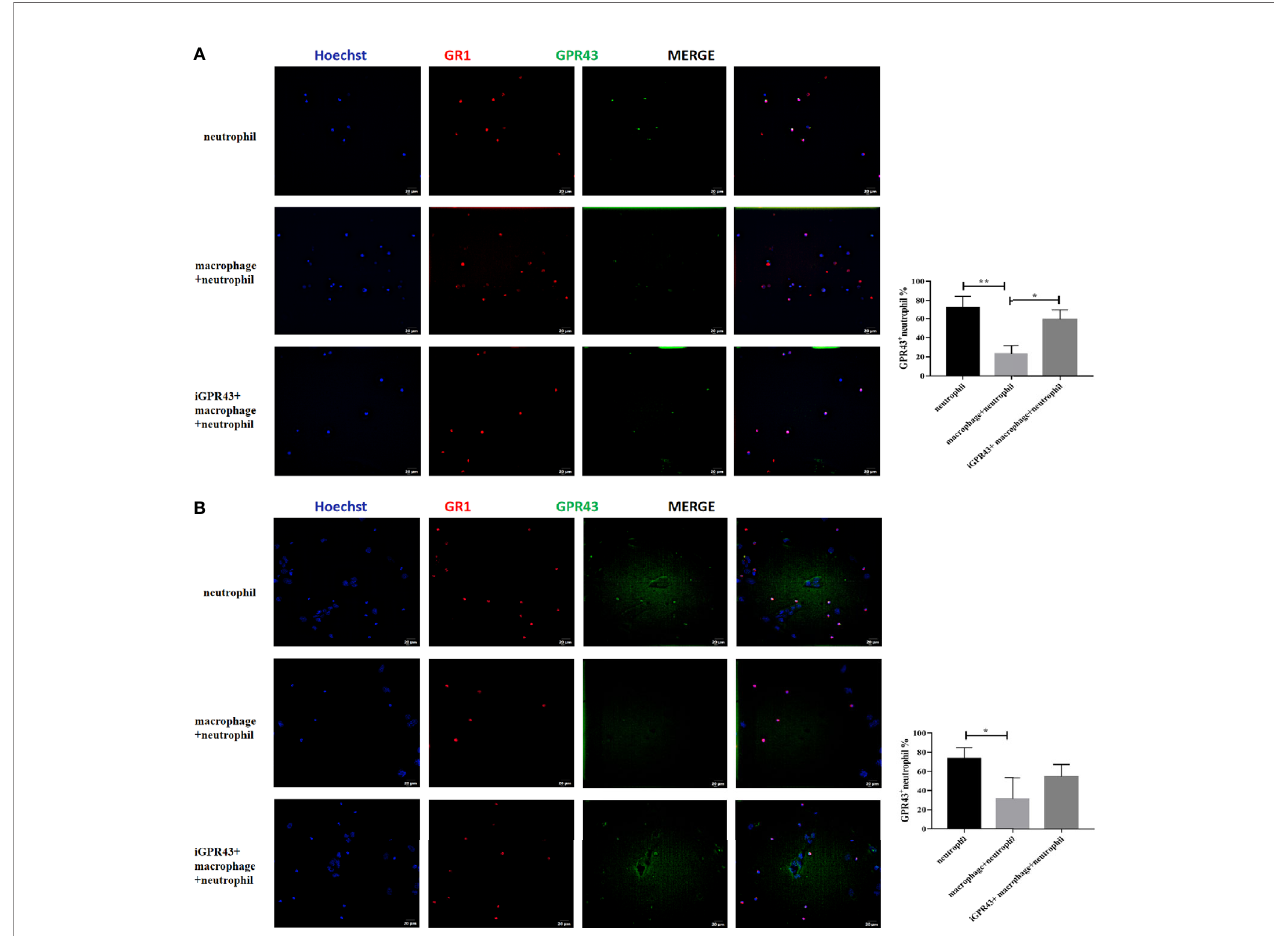
FIGURE 14 | Representative images of immuno fl uorescence staining of neutrophils and GPR43. (A) Macrophages were cocultured with neutrophils in non-transwell system with or without GPR43 antagonist. (B) Macrophages were cocultured with neutrophils in the upper chamber of transwell system with or without GPR43 antagonist. TCMK-1 cells were stimulated with CaOx crystals and LPS in the lower chamber of transwell system. 594 (GR1, red), and FITC (GPR43, green) fl uorescence images and merged images with Hoechst staining (blue) of the same visual fi eld are also shown. Statistically signi fi cant was shown as *p < 0.05, **p <